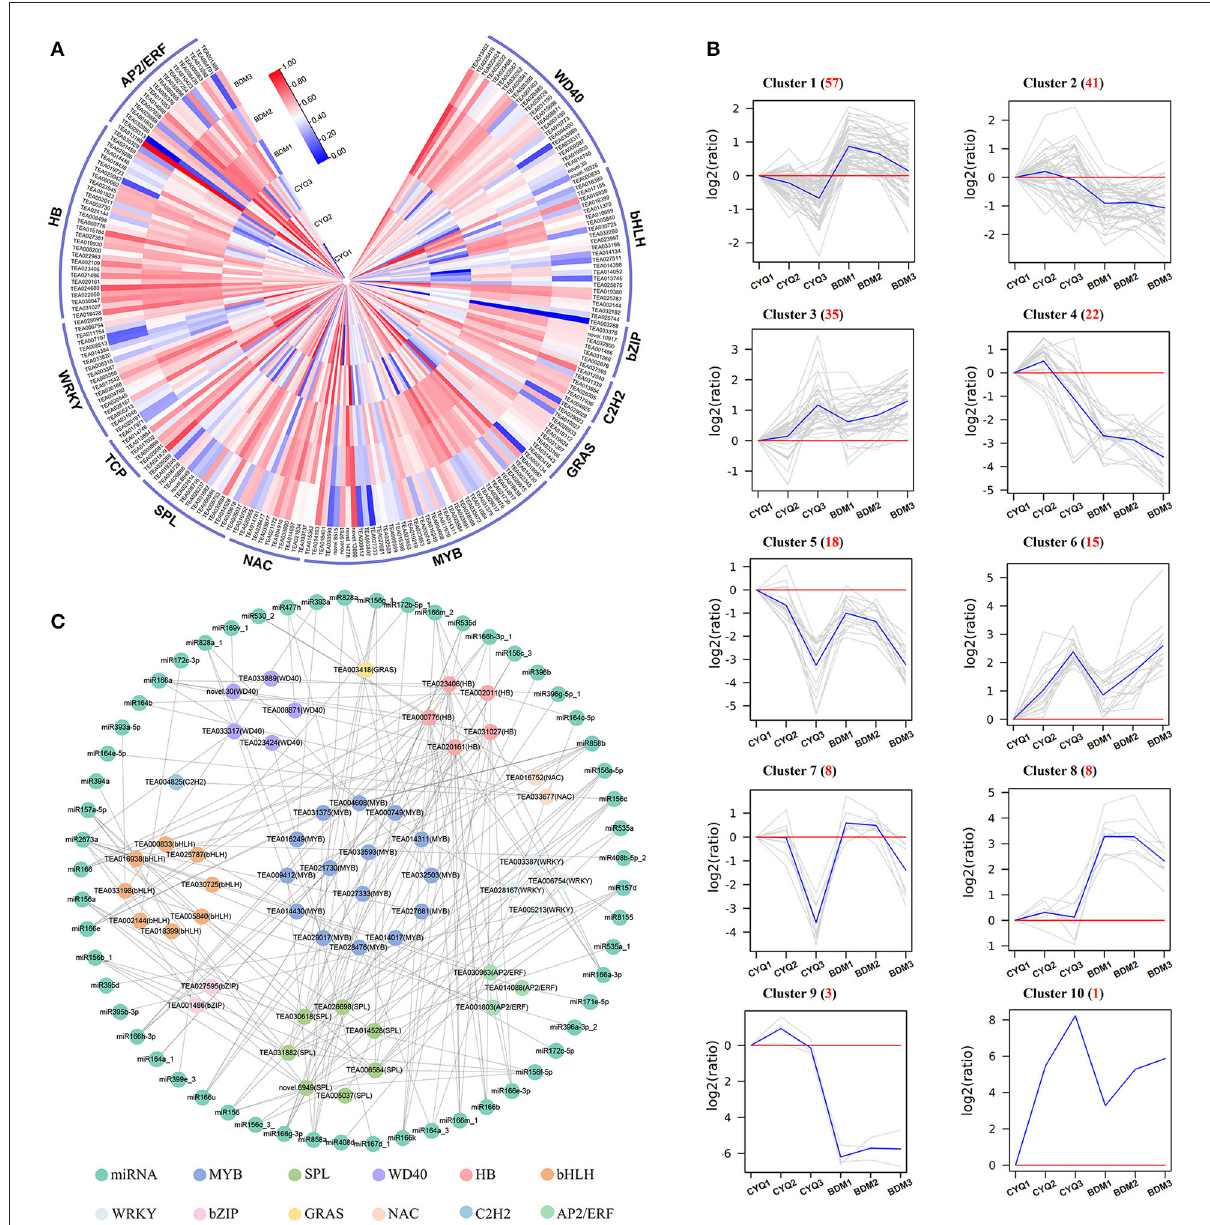
FIGURE5 The analyses of differentially expressed TFs. (A) The expression patterns of differentially expressed TFs. The expression levels of DEGs were normalized by log 2 (FPKM). (B) The clustering of differentially expressed TFs. Expression ratios were expressed as log 2 (ratio). (C) The TF-miRNA network of all the identified